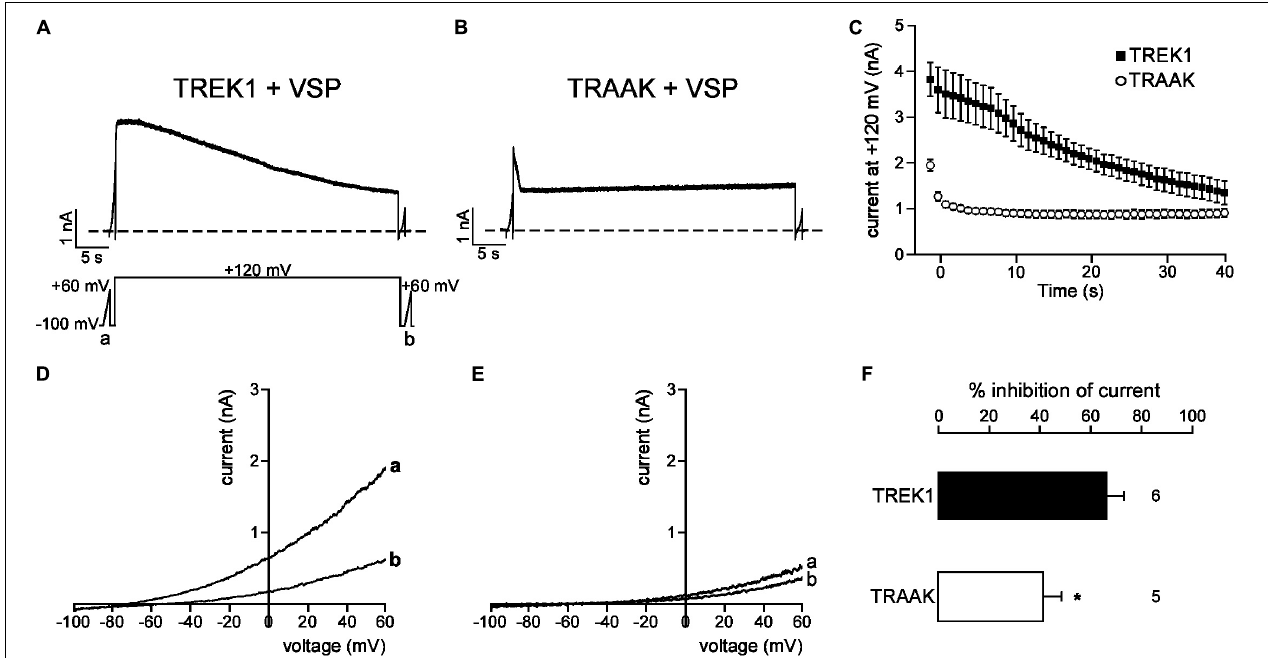
FIGURE 6 | PIP 2 depletion inhibits TREK1 and TRAAK currents. (A,B) Representative perforated patch-clamp recordings from HEK cells co-expressing VSP and TREK1 (A) or TRAAK (B) . (C) Average currents measured at +120 mV during VSP-induced PIP 2 depletion. (D,E) , TREK1 (D) and TRAAK (E) currents before (a) and